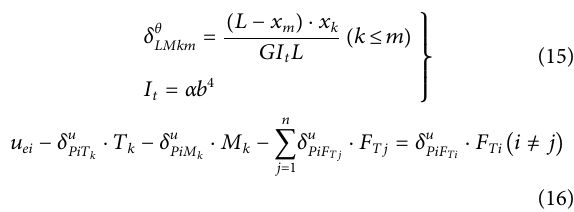
FIGURE 5 Schematic diagram of the calculation of the top beam angular displacement δ θ LMkm under a unit force